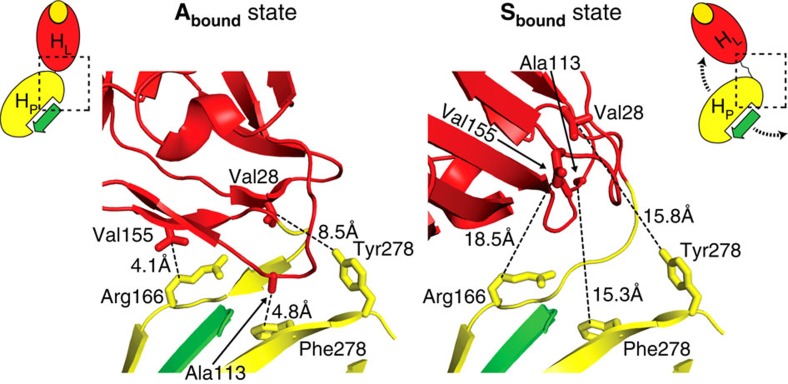
The interdomain region in the Sbound state.Close-up of the interdomain region of FimHK12·DsF·HM in the Abound form (left) and FimHK12·DsF·HM in the Sbound state (right). A cartoon representation for each crystal structure, similar to Fig. 1a, is given. Key residues in the interface are shown as sticks. FimHP, FimHL and DsF are coloured in yellow, red and green, respectively.